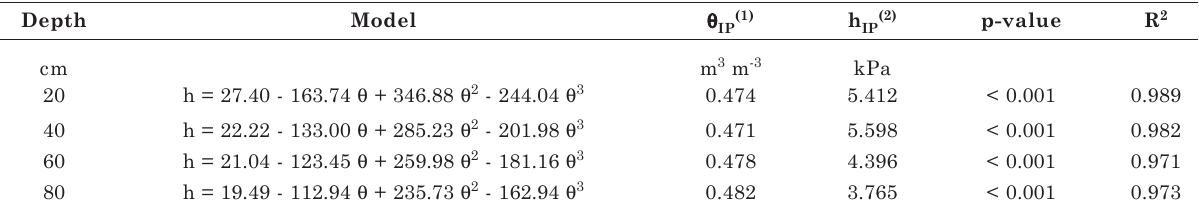
at the inflection point.